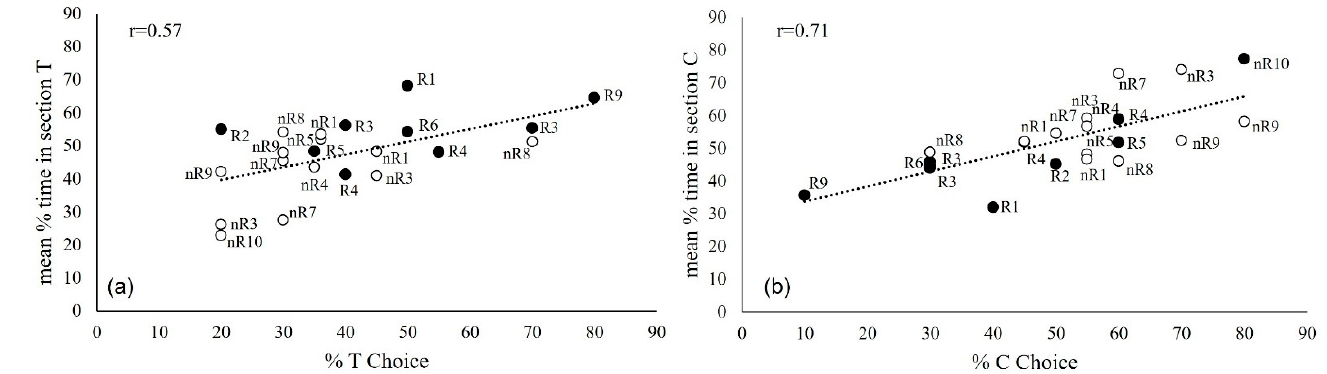
Figure 5. Positive linear relationships (indicated by dotted regression lines) between mean relative time (mean % time) spent by male Ips typographus beetles in the section of final choice and proportion of choices (% choice) over all test runs of “T and C” experiments for ( a ) section T and choice T; Pearson correlation r = 0.57; n = 22; p = 0.05; ( b ) section C and choice C; Pearson correlation r = 0.71; n = 22; p < 0.001; nR trees: white circles; R trees: black circles; study trees tested against both controls, C1 and C2, are represented twice in the figures.